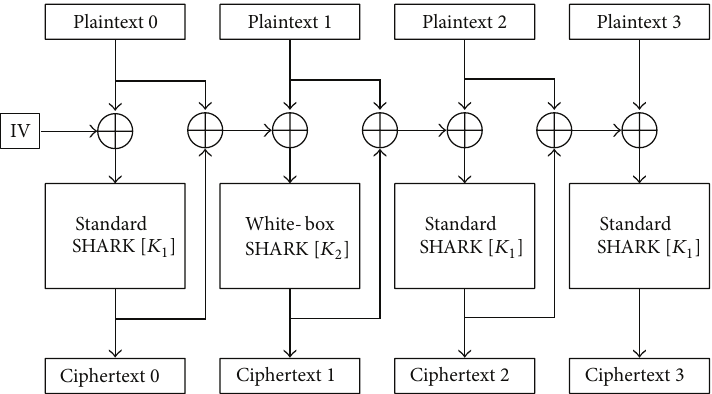
Figure 5: Flow of the white-box SHARK algorithm in composite PCBC mode.